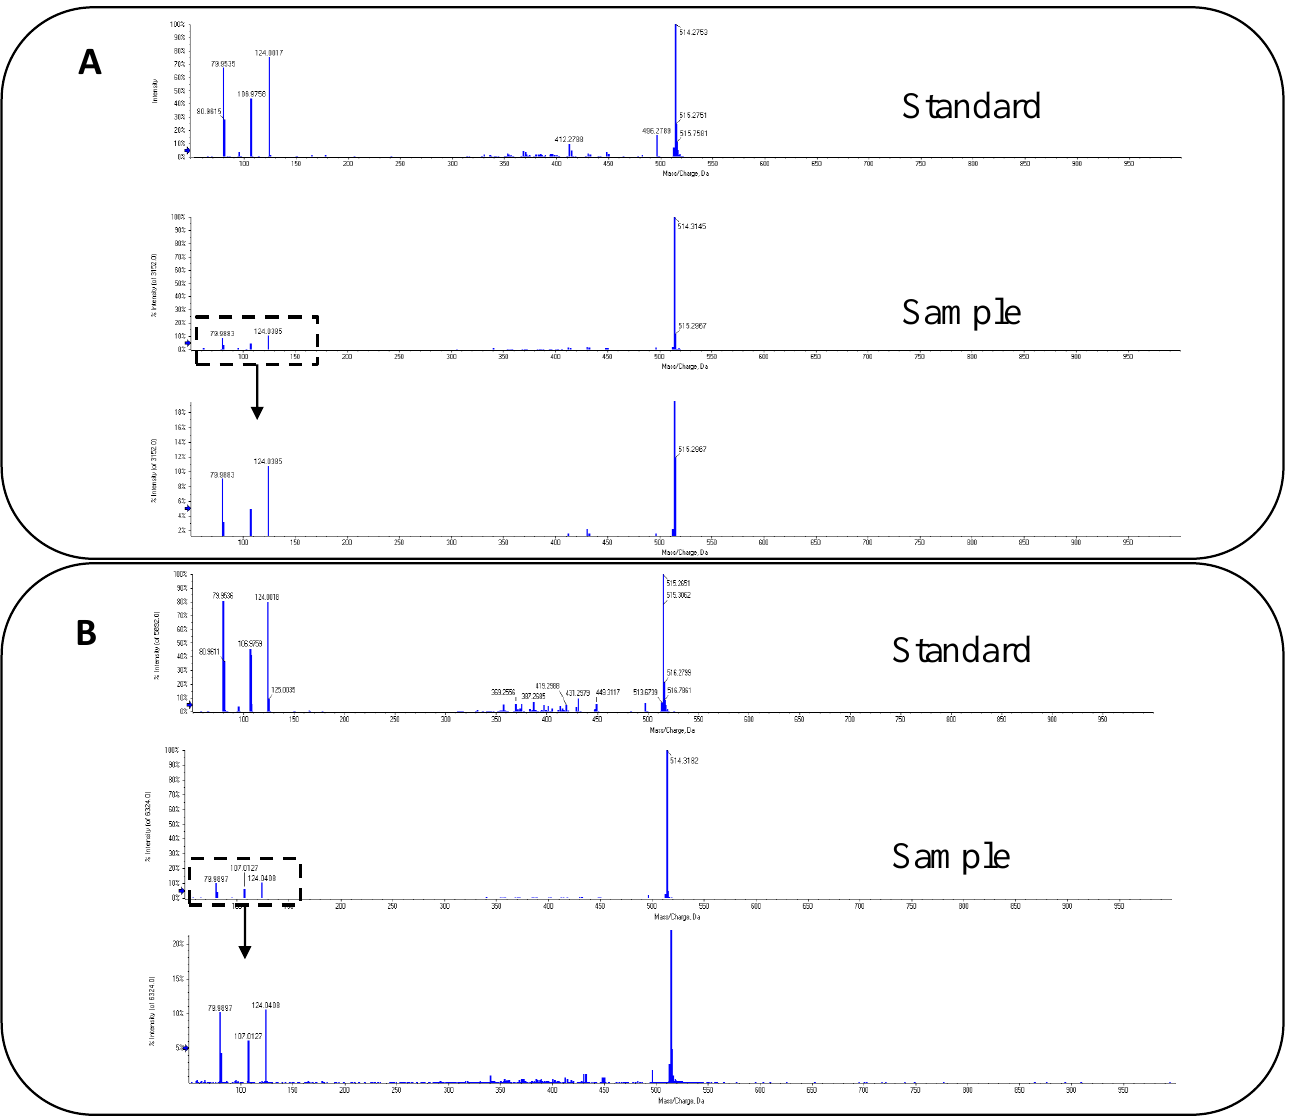
Figure 6. Tandem mass spectrometry (MS/MS) of TβMCA and T ω MCA in sample and standard. ( A ) for T β MCA, ( B ) for T ω MCA. The RT and abundance ratio of MS/MS of TβMCA and TωMCA standard were 2.79 min and 2.37 min, m / z 124.0017:106.9758:80.9615:79.9523 = 6:3:2:4 and m / z 124.0018: 106.9759:80.9611:79.9536 = 40:19:13:40, respectively, which in sample was consistent.